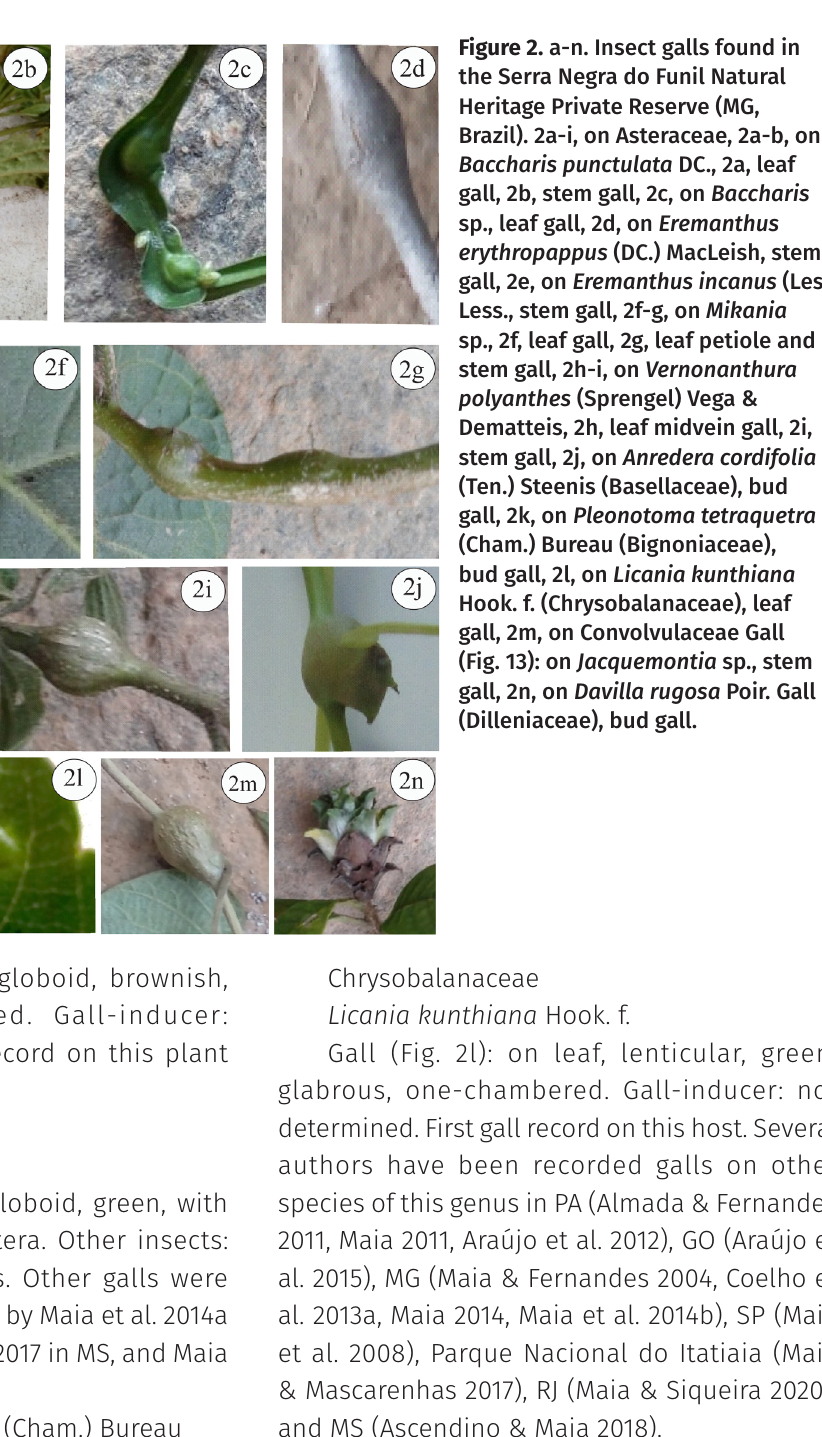
Figure 2. a-n. Insect galls found in the Serra Negra do Funil Natural Heritage Private Reserve (MG, Brazil). 2a-i, on Asteraceae, 2a-b, on Baccharis punctulata DC., 2a, leaf gall, 2b, stem gall, 2c, on Baccharis